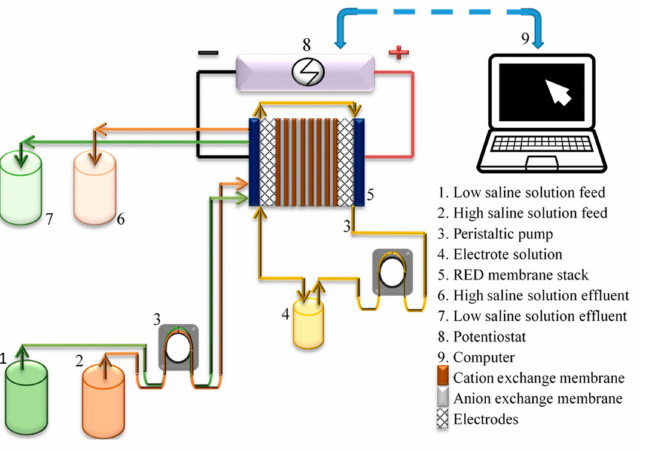
Figure 2. Flowsheet of the lab-scale RED system with 7 membrane pairs (8 CEM + 7